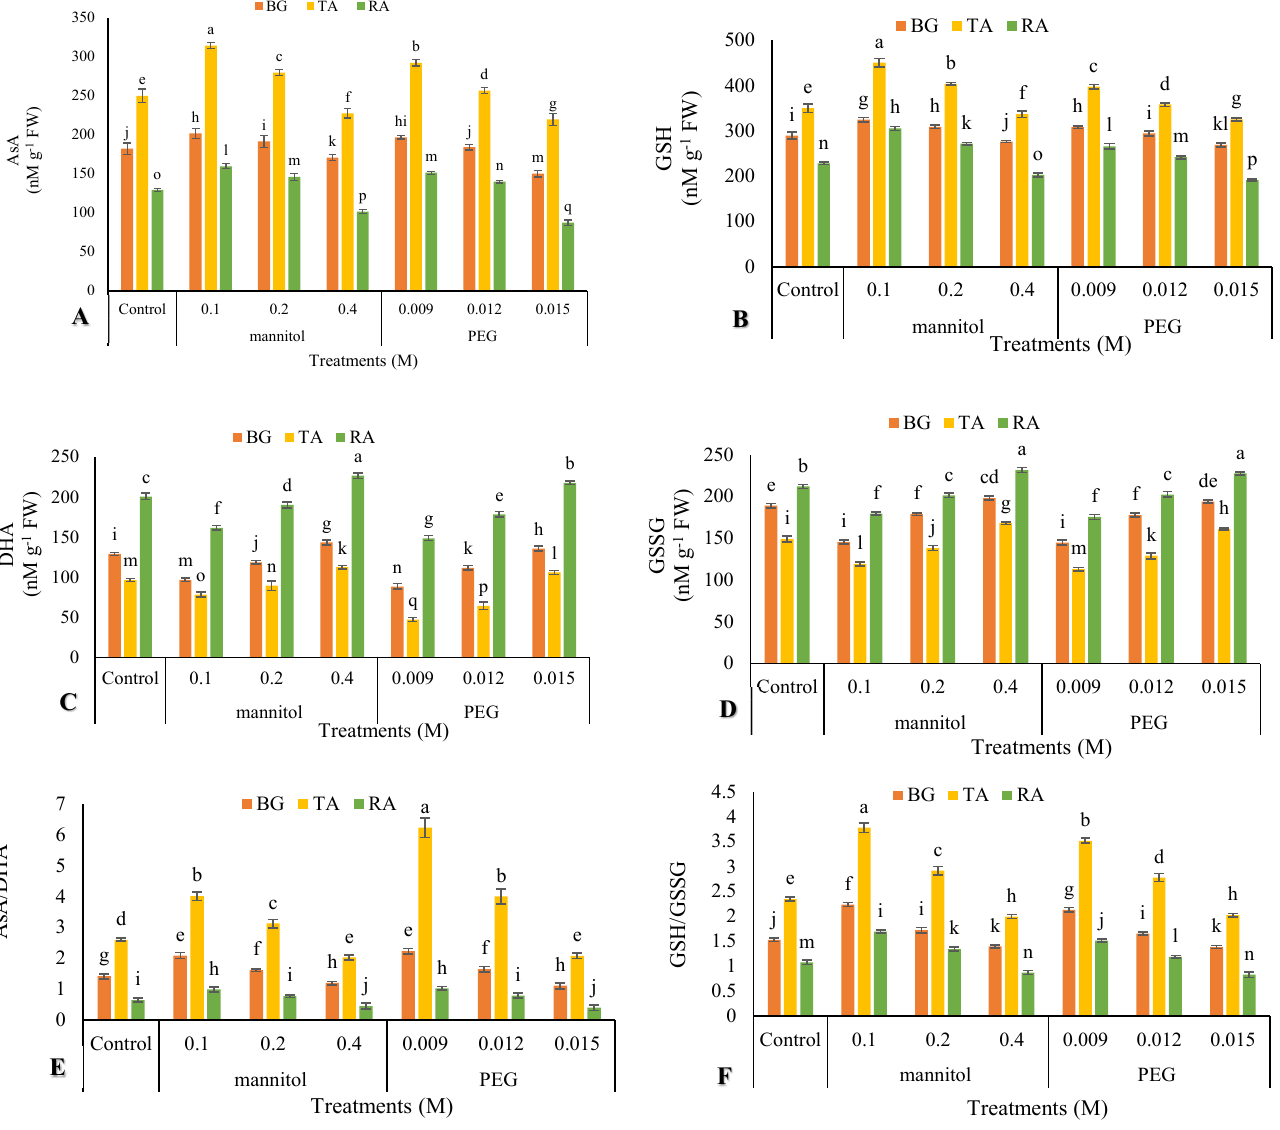
Figure 4. Effects of PEG and mannitol on (AsA) (nM g − 1 FW) ( A ), reduced glutathione (GSH) (nM g − 1 FW) ( B ), dehydroascorbate (DHA) (nM g − 1 FW) ( C ), oxidized glutathione (GSSG) (nM g − 1 FW) ( D ), ASA/DHA) ( E ), and GSH/GSSG ( F ) in Cucurbita sp. genotypes under in vitro conditions. Different letters are significantly different based on Duncan’s multiple range test ( p ≤ 0.05).